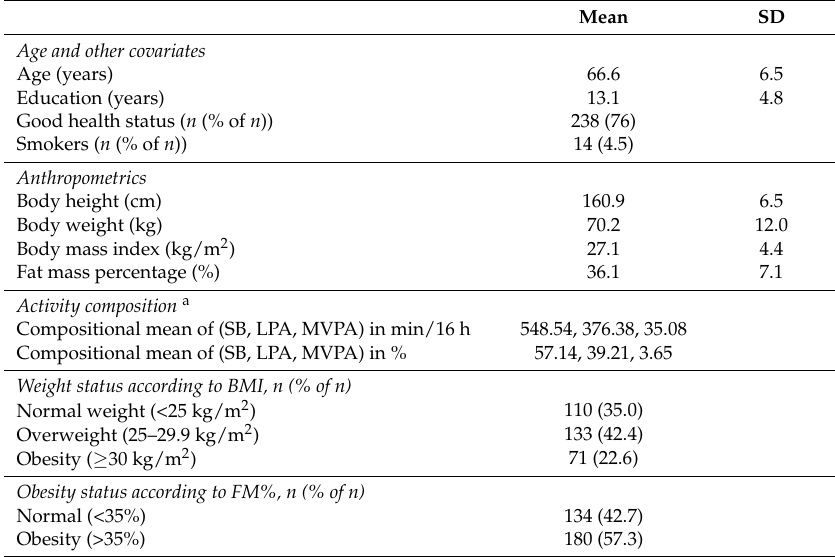
Table 1. Characteristics of the study sample.